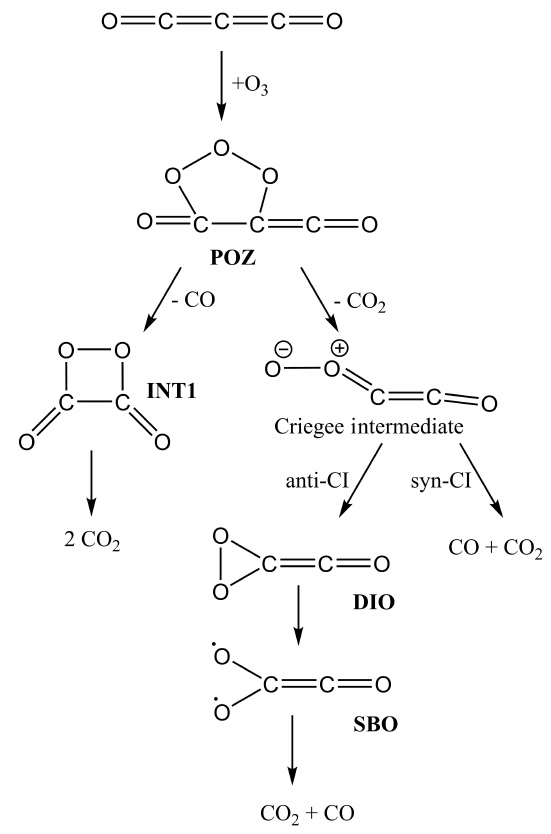
Figure 11. Simplified mechanism for the reaction of carbon sub- oxide with O 3 . Additional calculations are available in the Supple-